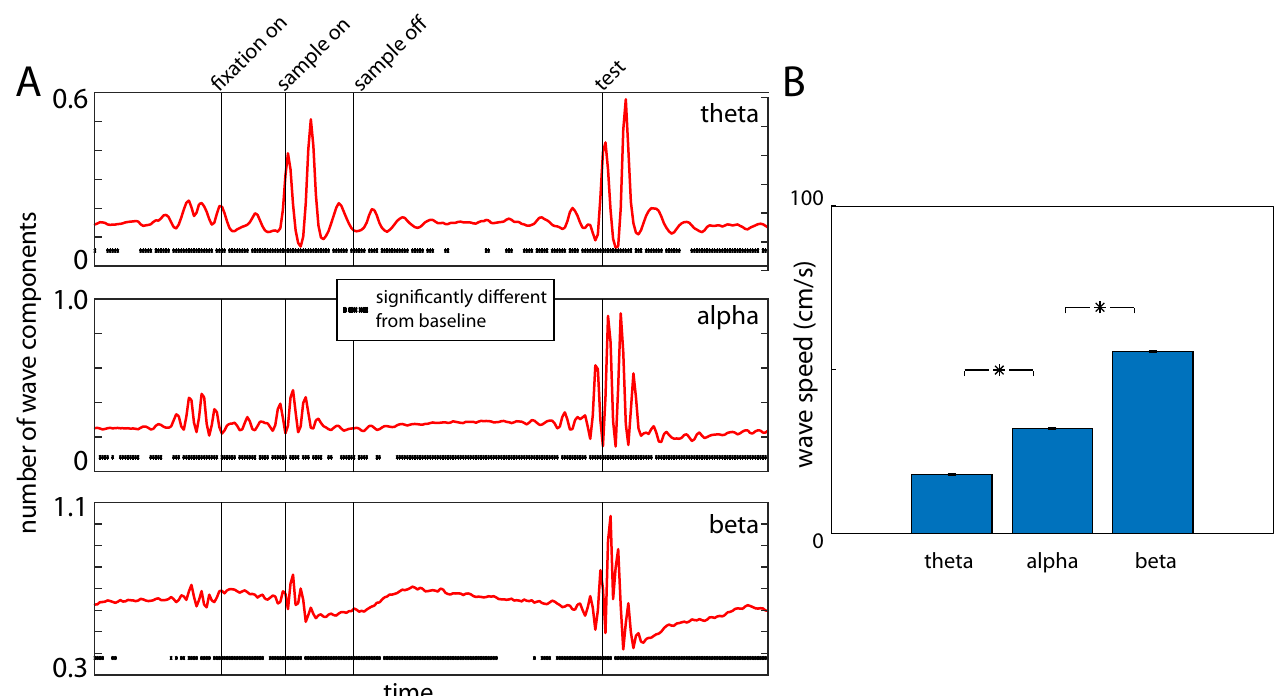
Fig 2. (A) Number of wave components observed in the three frequency ranges during the trial. The numbers are trial-averaged across all four arrays. The dots underneath denote if the numbers at that instant are significantly different from baseline (0.5s before fixation). (B) Wave speeds observed across all frequency ranges. Error bars represent SEM. Star indicates statistically significant difference (p <